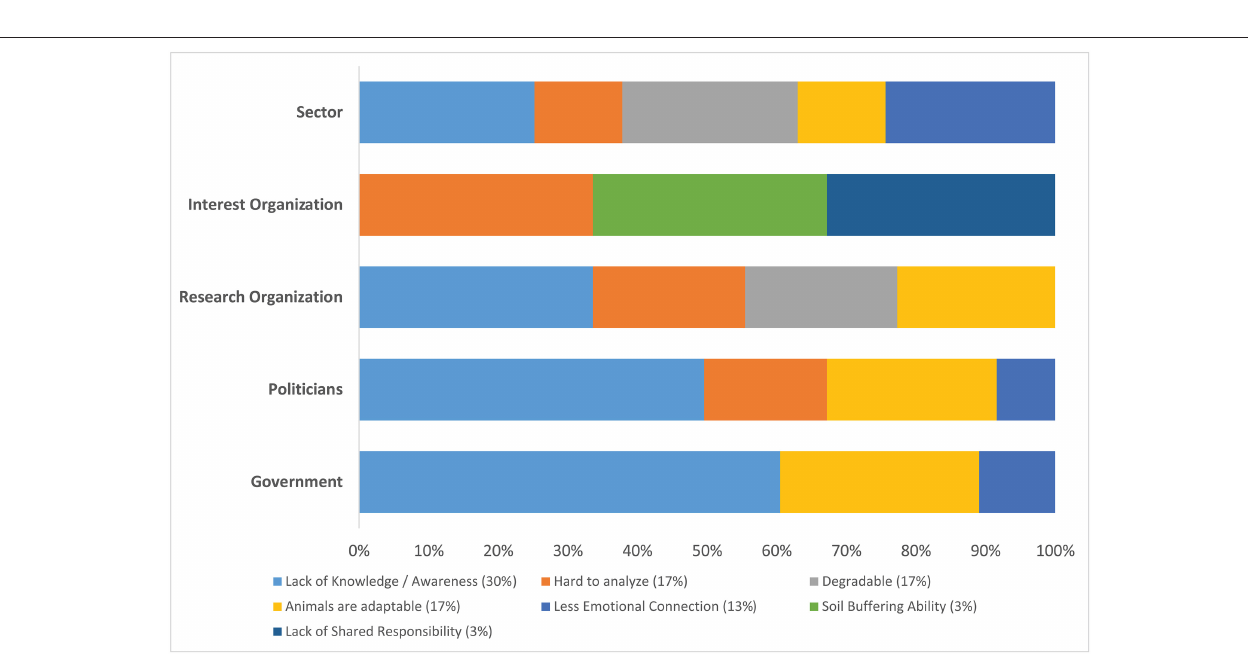
FIGURE 4 | Stakeholder perspectives on MPs in the terrestrial environment. Percentages reported represent the frequency with which an issue was mentioned across all stakeholders responding ( n = 28).